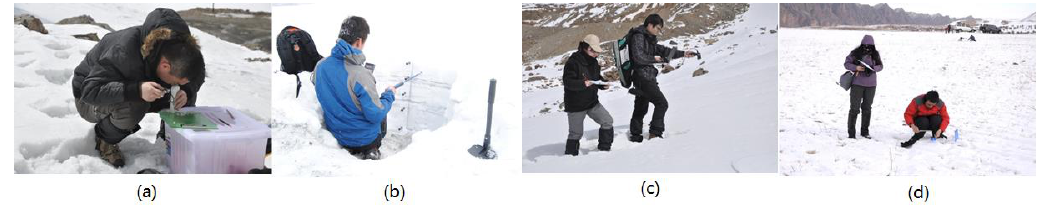
Figure 4. Field observation photographs of measurements of ( a ) grain size, ( b ) water extent, ( c ) reflectance and ( d ) density. ( c ) reflectance and ( d )